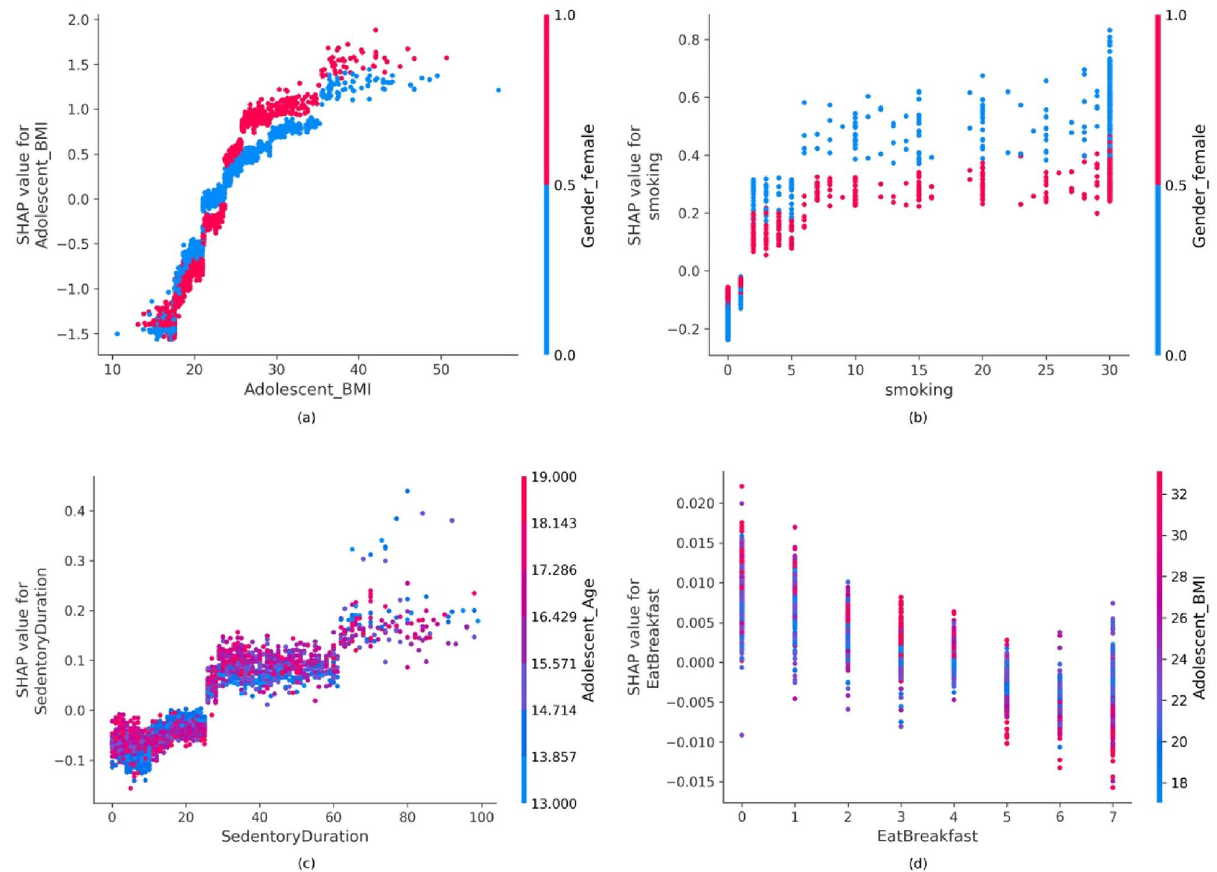
Figure 7. Partial dependence plots: ( a ) adolescent BMI, ( b ) cigarettes smoked per month, ( c ) hours of sedentary duration, ( d ) breakfast frequency. SHAP values greter than zero indicates a positive correlation between the two adolescent risk